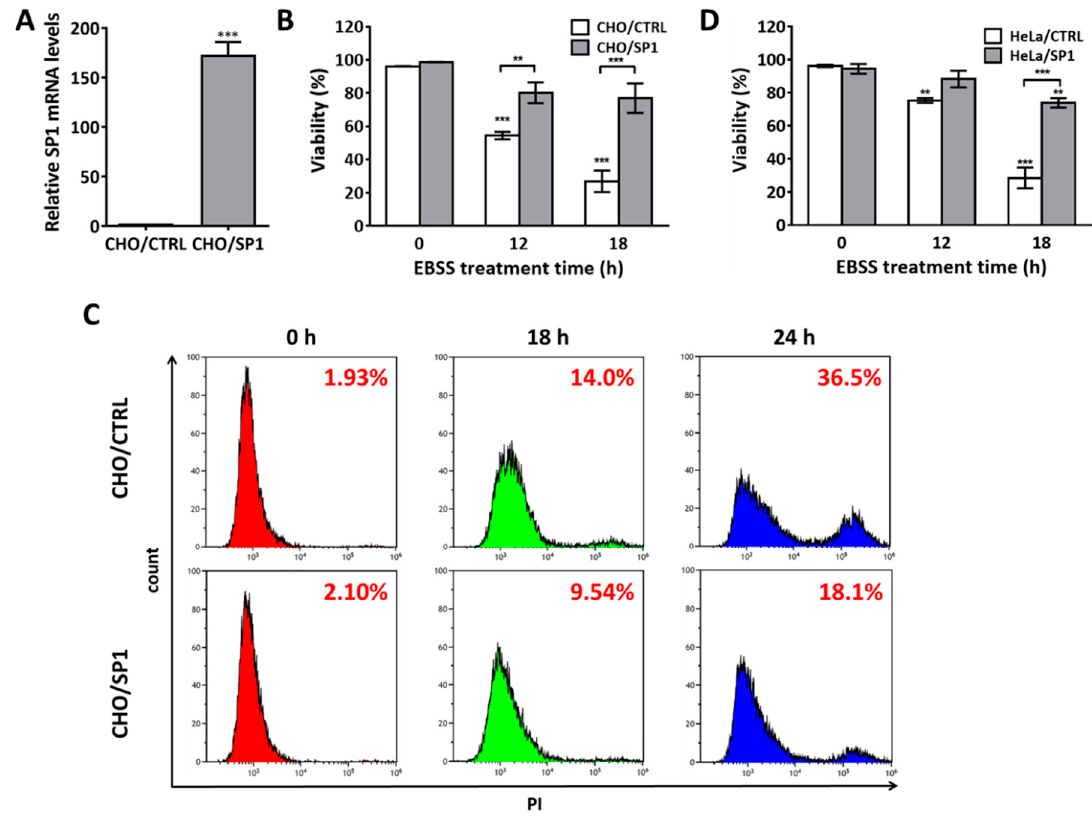
Figure 1. SP1 inhibits autophagy-mediated cell death induced by Earle’s balanced salt solution (EBSS) treatment. ( A ) The expression of SP1 messenger RNA (mRNA) in each cell line was confirmed by reverse transcriptase polymerase chain reaction (PCR) analysis. ( B ) The effect of SP1 on cell death in the Chinese hamster ovary (CHO) cells treated with EBSS for 0, 12, and 18 h. Cell viability was measured by performing the Trypan blue dye exclusion assay. ( C ) Flow cytometry analysis of cell death before and after the EBSS treatment in the CHO/CTRL and CHO/SP1 cells. The cells were treated with EBSS for 0, 18, and 24 h, and were stained with PI before performing the flow cytometry analysis. ( D ) The effect of SP1 on autophagy-mediated cell death in the HeLa cells treated with EBSS. All values are represented as mean ± SD (** p < 0.01 and *** p < 0.001; n = 3).